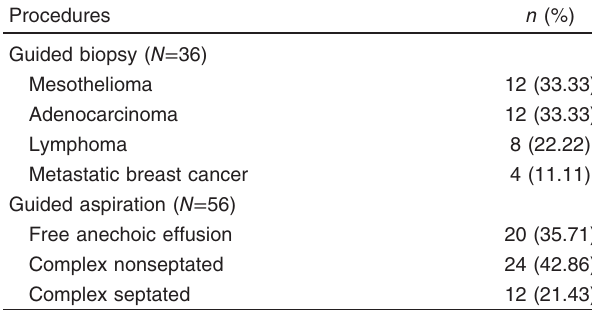
Table 4 Descriptive analysis of the studied group regarding ultrasonographic-guided procedures